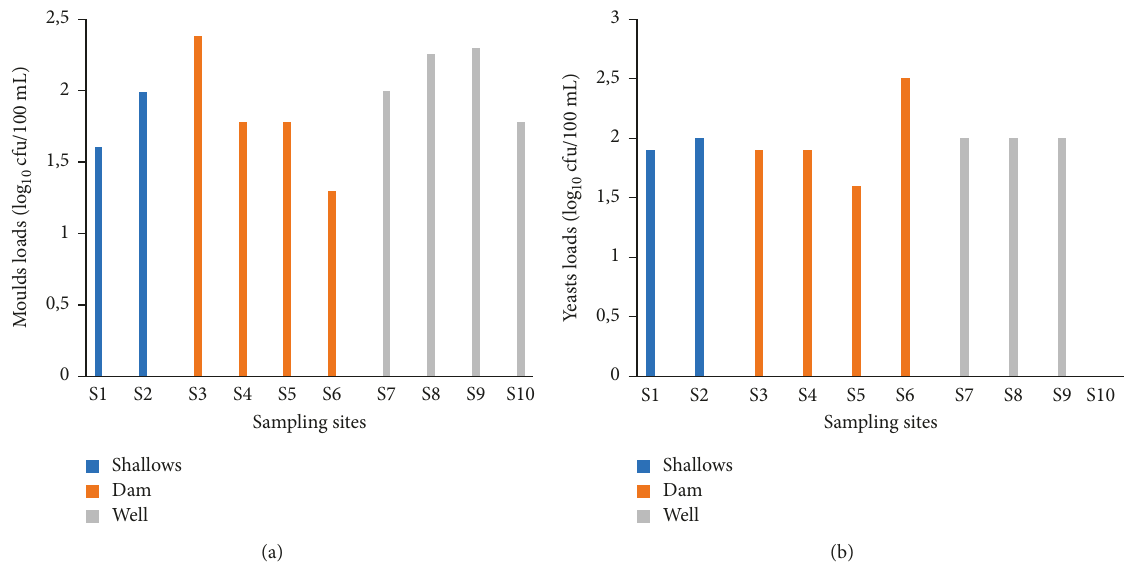
Figure 5: Moulds (a) and yeasts (b) counts in irrigation water.